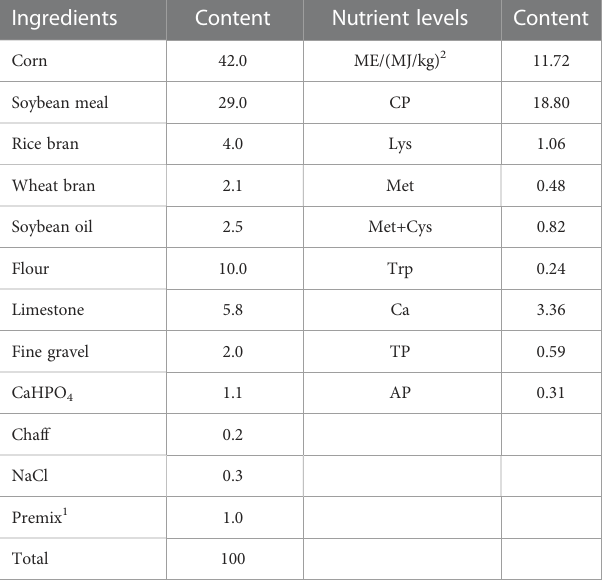
TABLE 1 Composition and nutrient levels of basal diets (air-dry basis)